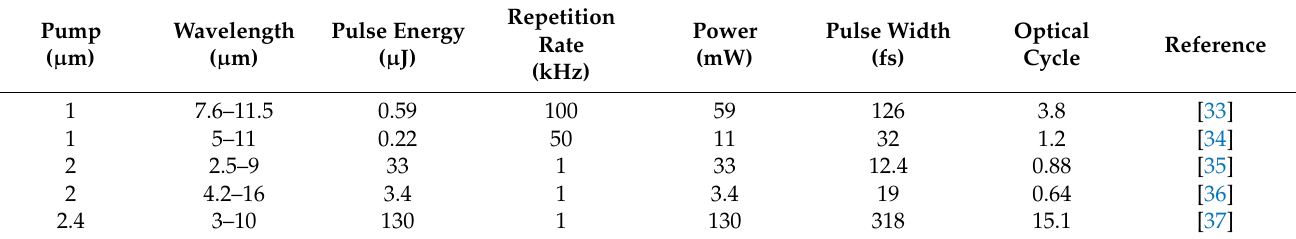
Table 2. Parameters of selected OPA system pumped by 1 and 2 µ